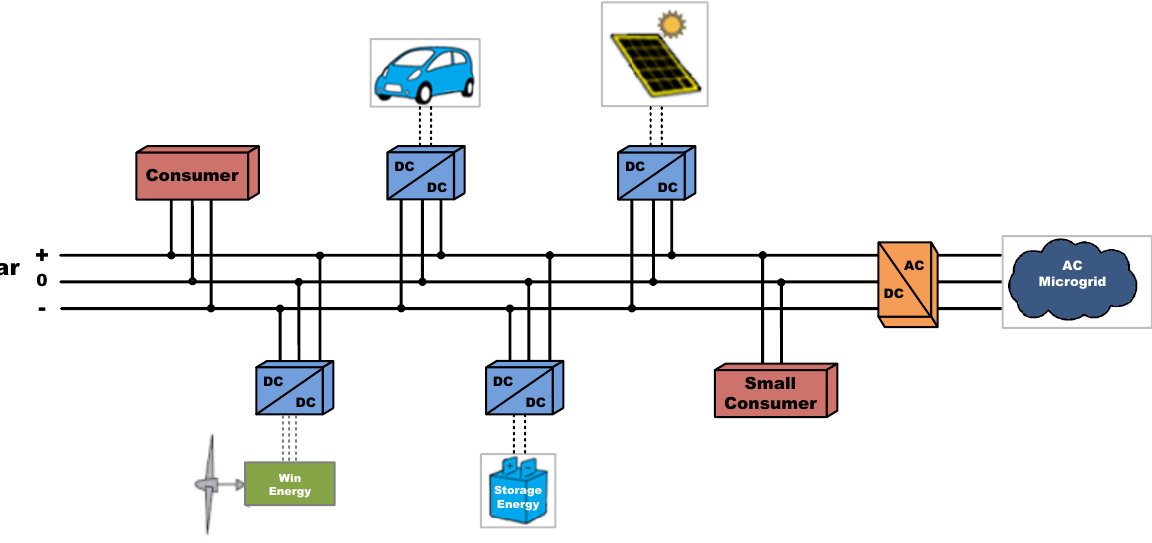
Figure 17. Bipolar DC microgrid .